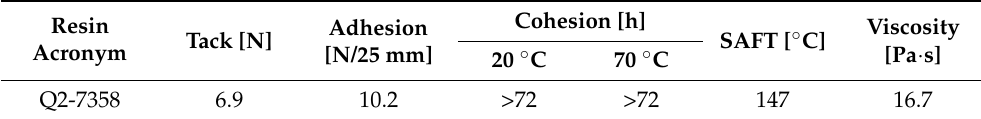
Table 3. Physical properties of base silicon adhesive (without filler).